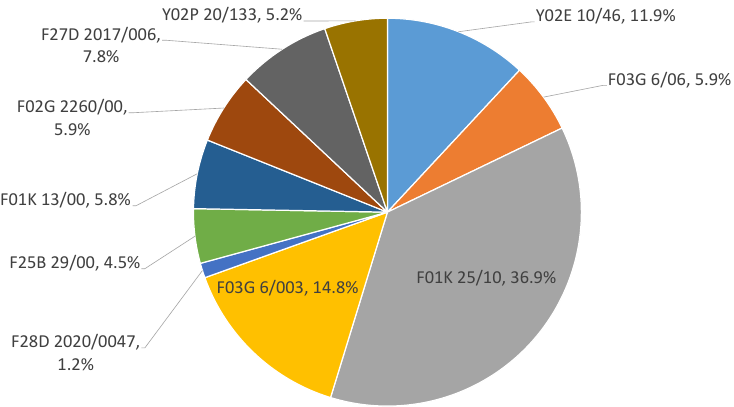
Figure 9. Patent distribution according to the IPC.